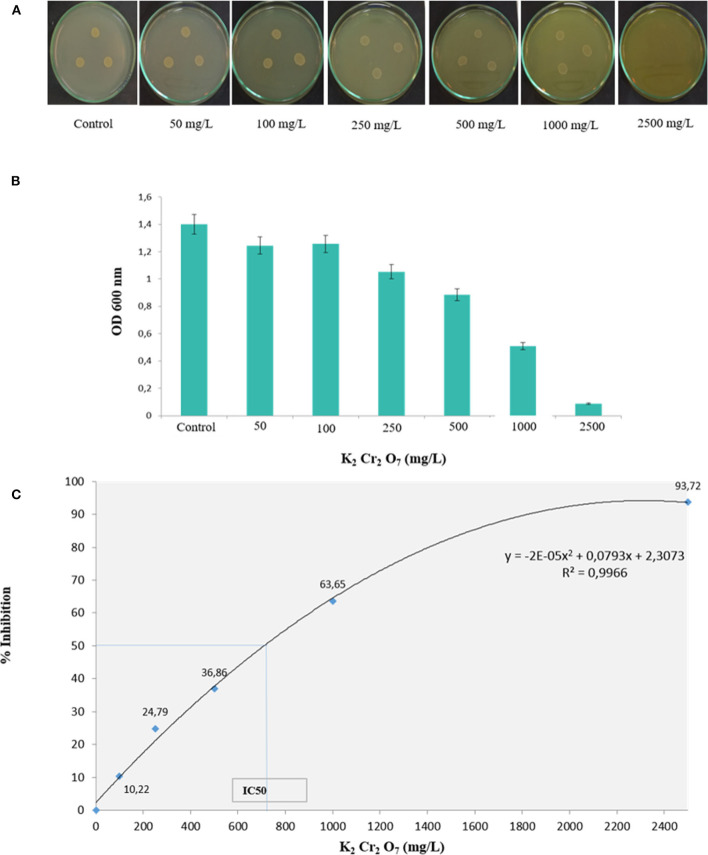
Effect of chromium concentration on TL13 bacterial growth on (A) tryptic soy agar (TSA) medium and (B) tryptic soy broth (TSB) medium; (C) chromium dose–response curve and determination of the IC50.